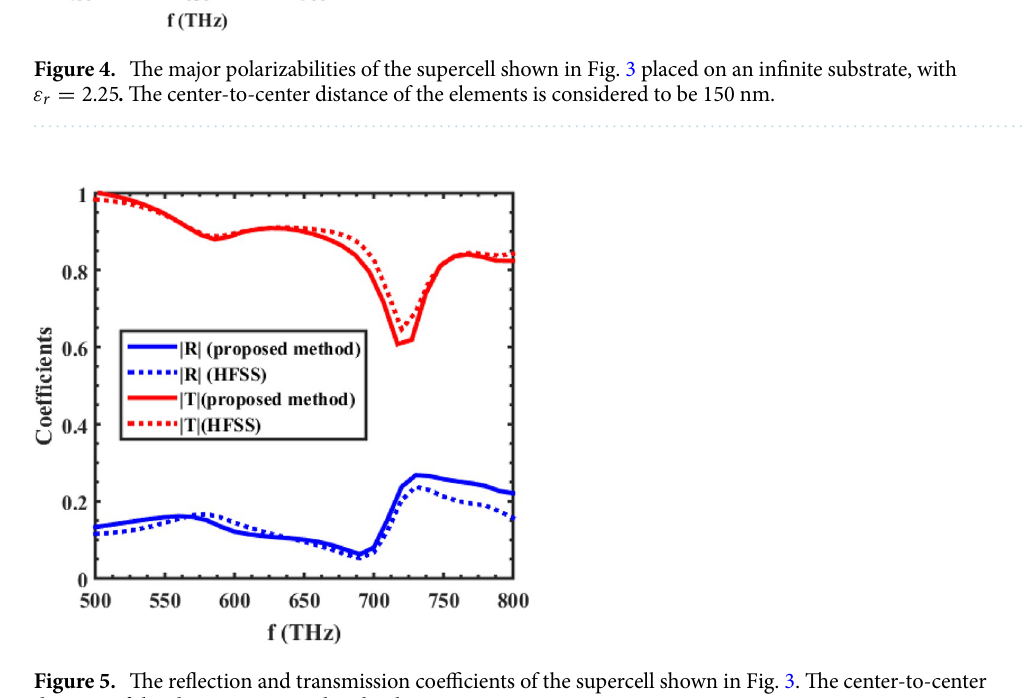
Figure 5. The reflection and transmission coefficients of the supercell shown in Fig. 3. The center-to-center distance of the elements is considered to be 150